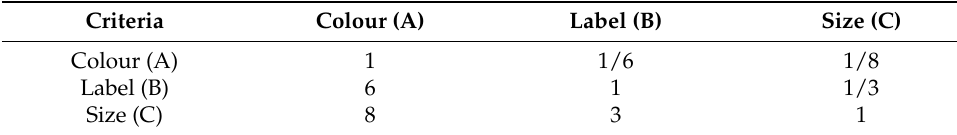
Table 10. Complete comparison matrix A1.